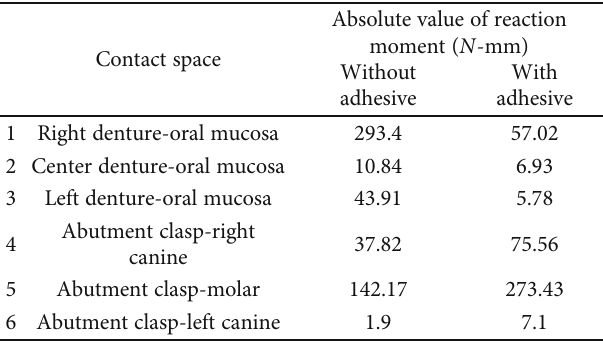
Table 4: Summary of the reaction moments generated at the major contact spaces in the assembly due to the applied bite force on the right denture